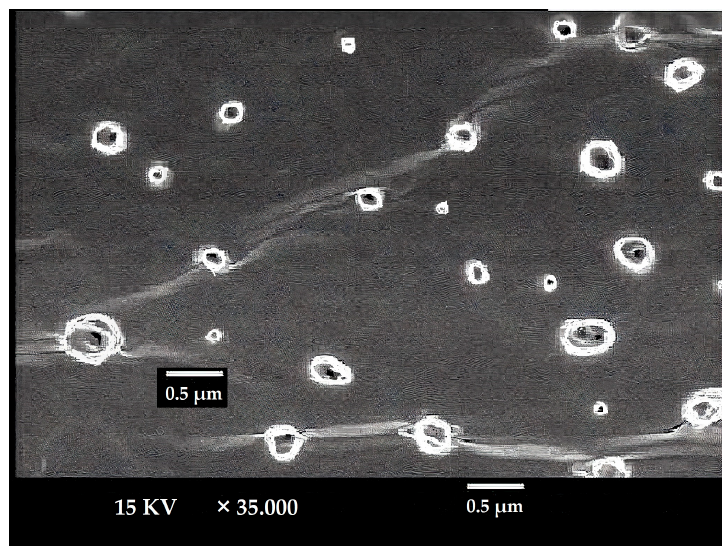
Figure 3. SEM micrograph of selected LUT ethosomes